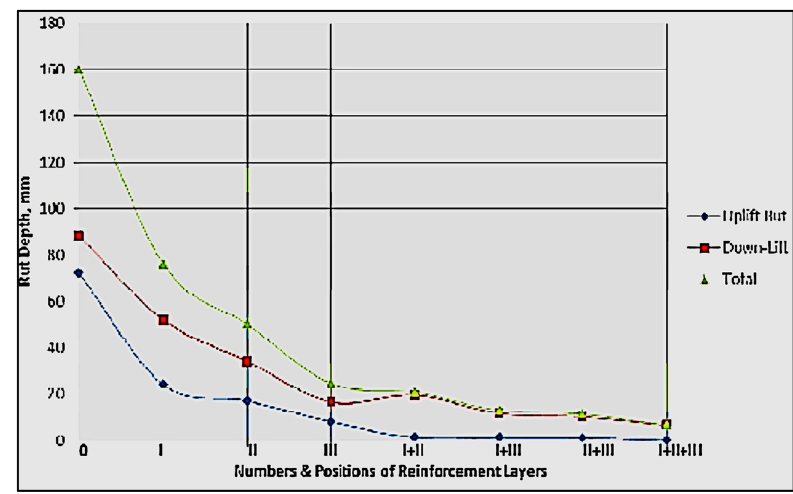
Figure 21: Rutting depth at di ff erent numbers and positions of reinforcement layers under 10,000 load cycles.